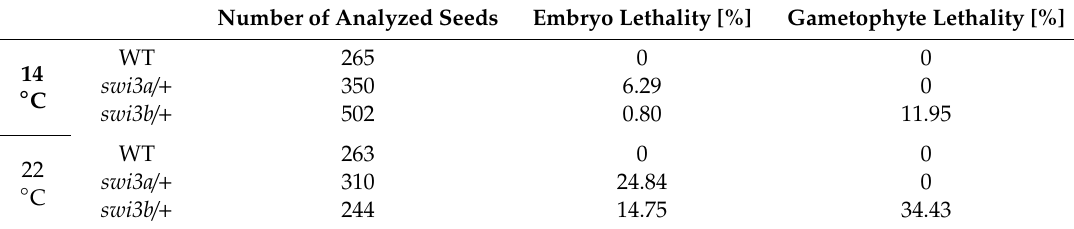
Table 1. The e ff ect of decreased growth temperature on swi3a and swi3b embryo development. Number of Analyzed Seeds Embryo Lethality [%] Gametophyte Lethality